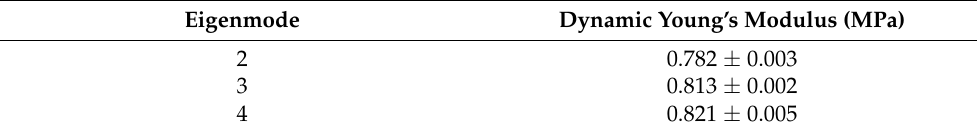
Table 2. Experimental dynamic Young’s modulus.